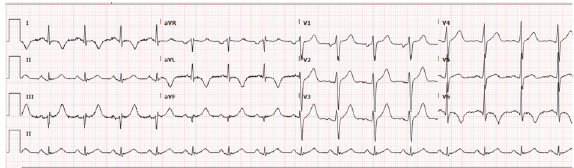
Figure 1: 12-lead EKG manifestation of anterolateral ischemia as lateral lead T-wave inversion without ST-segment elevation.